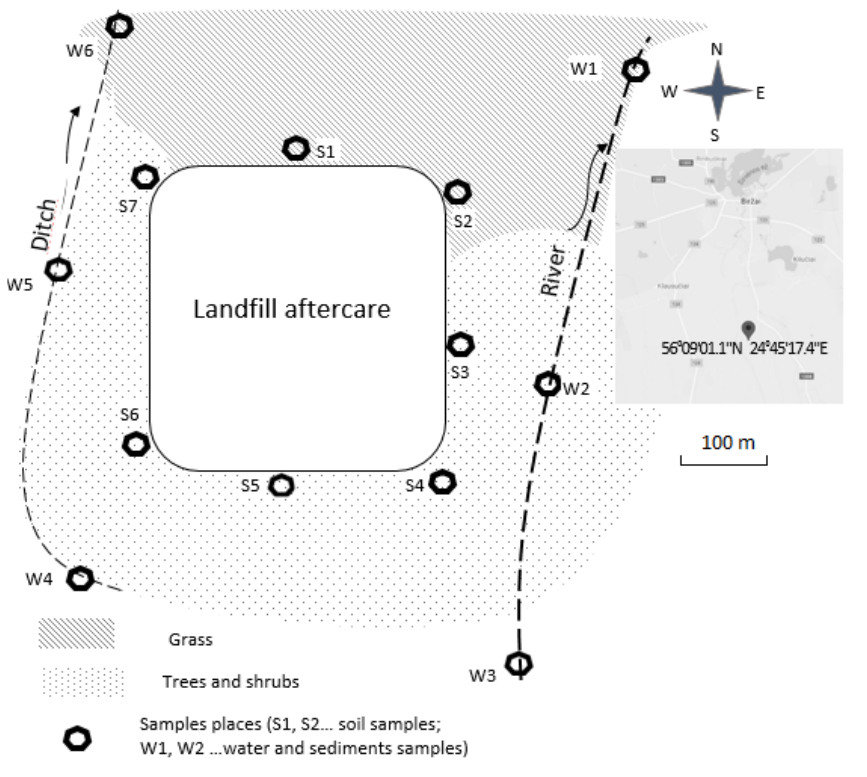
Figure 1. The scheme of sample points.